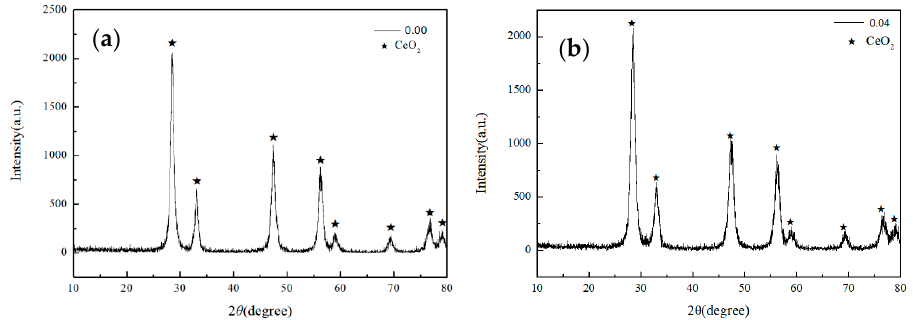
Figure 13. XRD analysis of the products CeO 2 when the mass fraction of citric acid changed: ( a ) 0.00 and ( b ) 0.04.